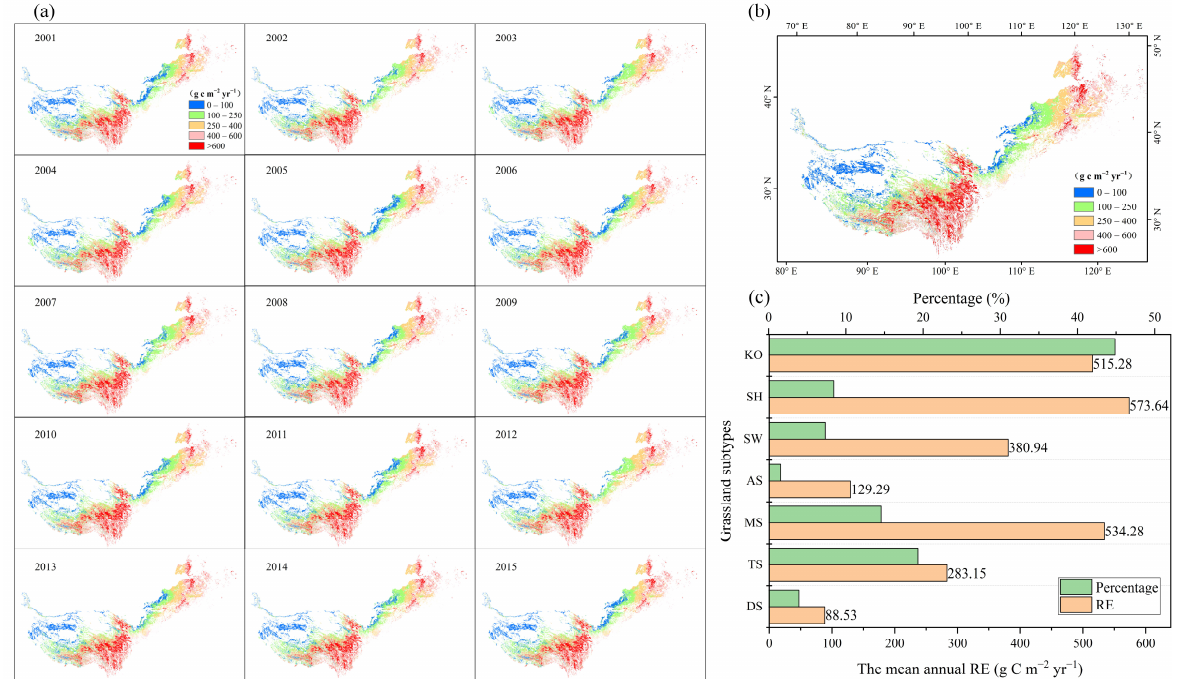
Figure 5. ( a ) Spatial distribution for RE in northern China’s grasslands from 2001 to 2015; ( b ) the mean annual RE for grassland in northern China; ( c ) Mean annual RE magnitudes for the seven grassland subtypes and the area weighted percentages to total RE.